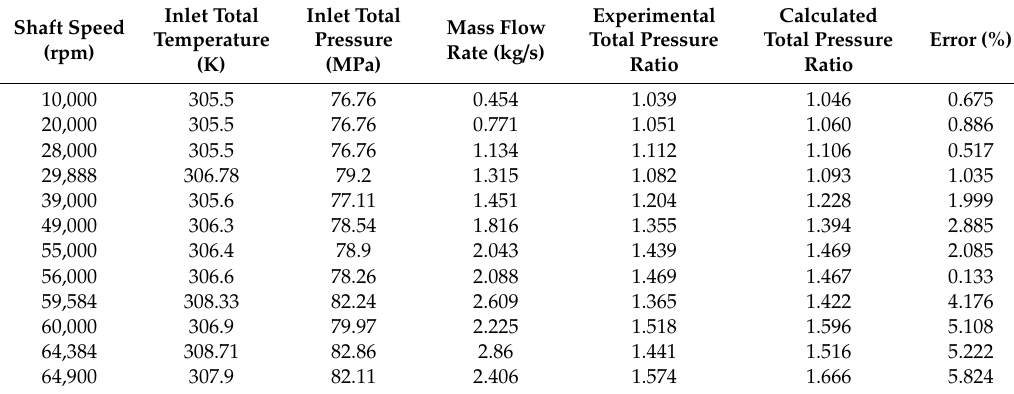
Table 3. Comparison of the predicted and measured total pressure ratio of the Sandia SCO 2 compressor at di ff user